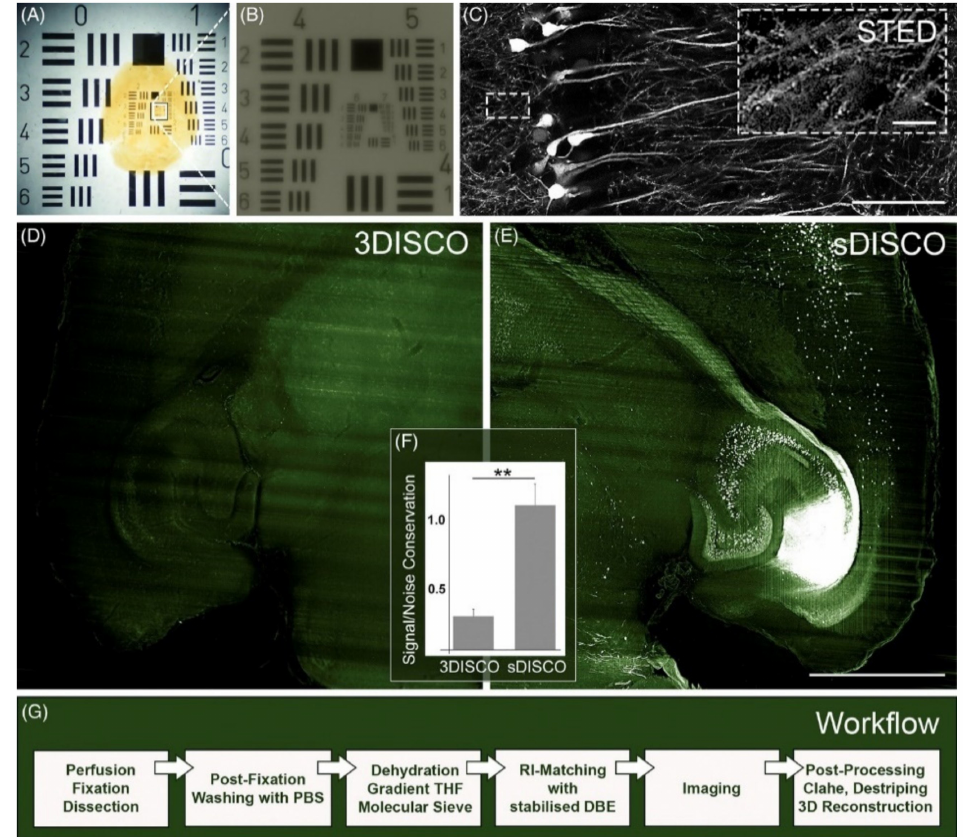
Figure 4. sDISCO greatly stabilizes fluorophores and allows for SRM-based studies. sDISCO achieves transparency of the ( A ) entire mouse brain ( B ) down to 2 µ m that is ( C ) compatible with SRM imaging. ( C ) In the overview and detailed image, the thick slice of a Thy1–YFP–H mouse brain was acquired by confocal microscopy using a 40 × objective and STED microscopy using a 100 × objective, respectively. The scale bars represent 50 µ m in the overview image and 5 µ m in the inset. ( D – F ) sDISCO greatly stabilizes fluorophores even months after the completion of clearing, and ( G ) the effect is achievable with a straightforward protocol. Reproduced from Hahn et al. [61] with permission. ** p <